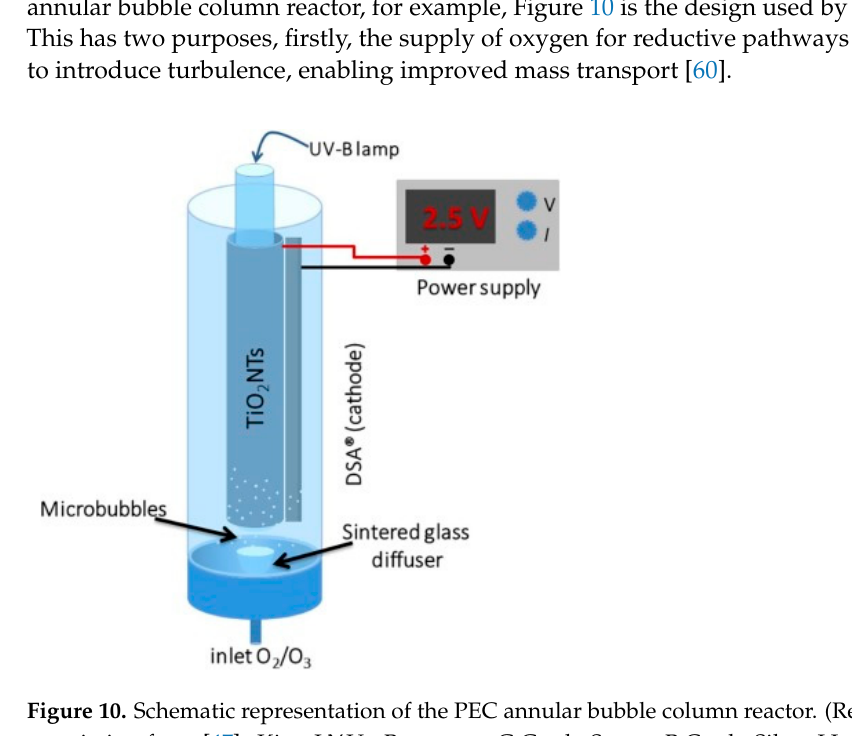
10 of 34 Figure 9. ( a ) Schematic representation of the experimental set-up, ( b ) PEC reactor cross-sectional